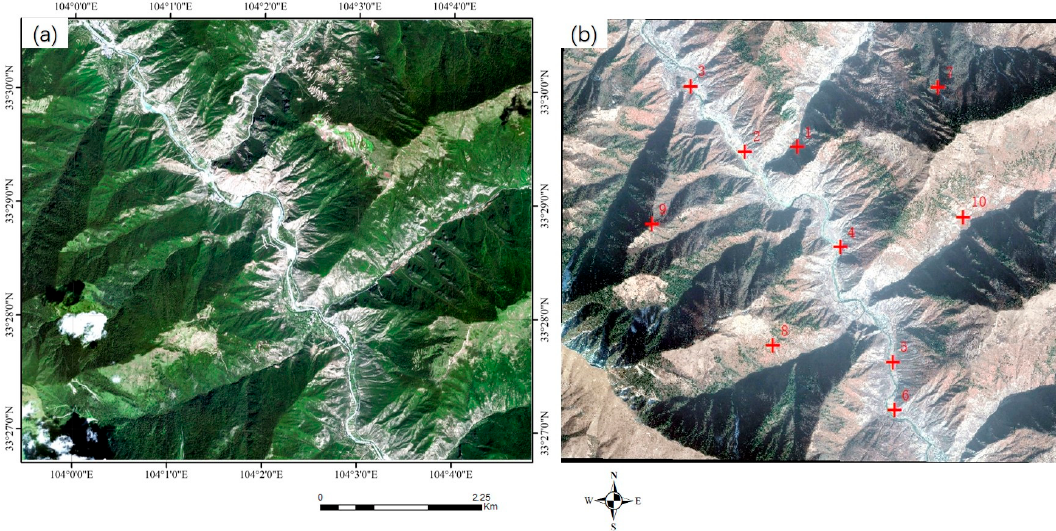
Figure 10. The Jiuzhaigou earthquake dataset. The left ( a ) is the post-earthquake image (the input image), and the right ( b ) is the reference image in the pre-earthquake database. The points in red are the verification points used for calculating the accuracy of the rectified image. According to the characteristics of the three datasets, the parameter settings of the proposed method are presented in Table 3.